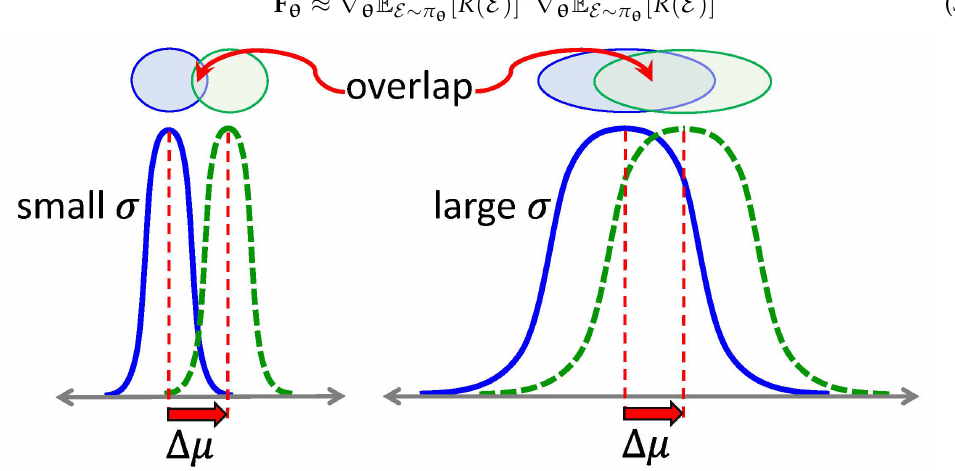
Figure 10. K-L Divergence. Two Gaussian distributions (solid, blue) with low variance σ ( left ) and high variance σ ( right ) are shown, and θ = [ µ , σ ] . Incrementing µ by ∆ µ (dashed green) results in equal change in the norm (cid:107) ∆ θ 1 (cid:107) whereas D KL ( π θ (cid:107) π θ + ∆ θ ) is higher in the distribution appearing to the left. The smaller distance in the right is due to the greater overlapping region shown on